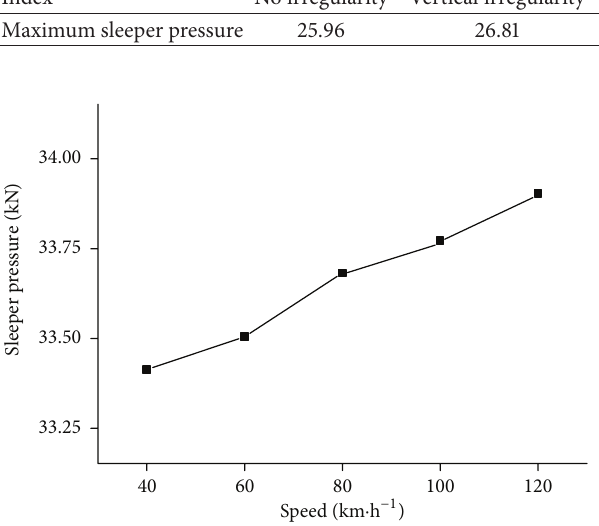
Figure 15: Effect of vehicle speed on the sleeper pressure.